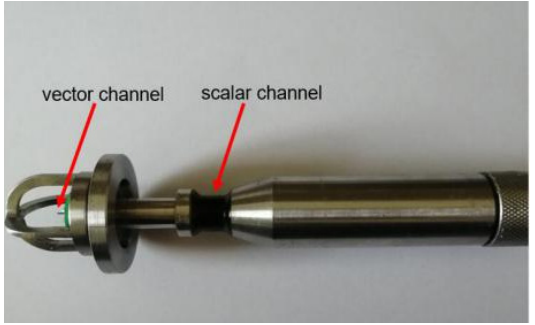
Figure 14. A physical picture of the composite hydrophone.